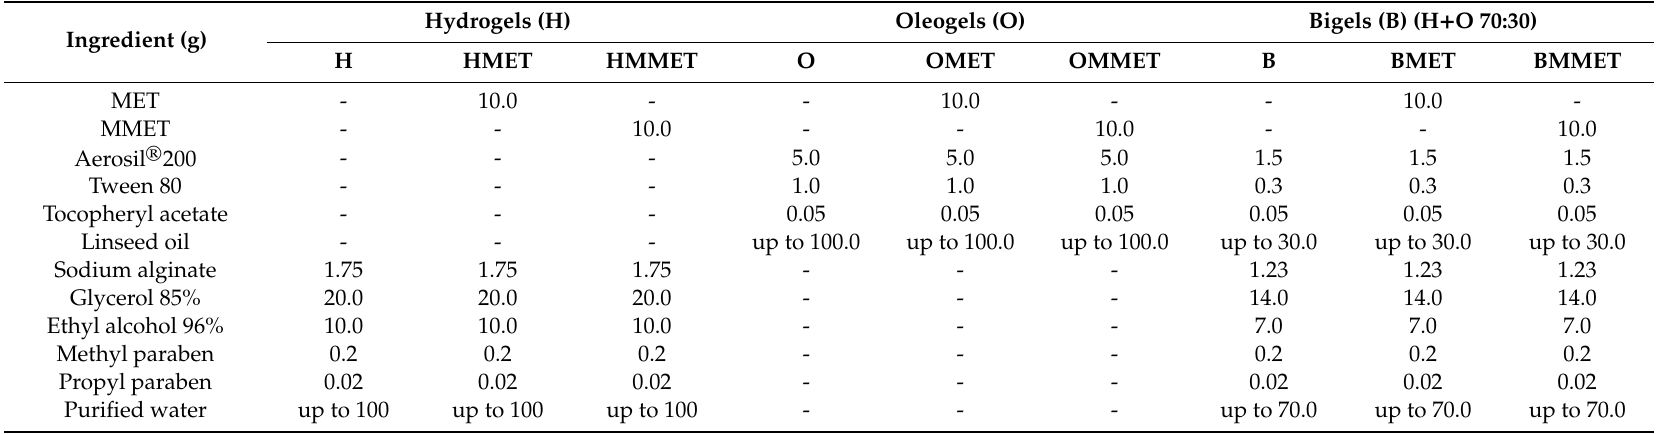
Table 1. Compositions of designed placebo hydrogel (H), oleogel (O), bigel (B), hydrogels, oleogels and bigels containing unprocessed MET (HMET, OMET, BMET) or micronized MMET (HMMET, OMMET,